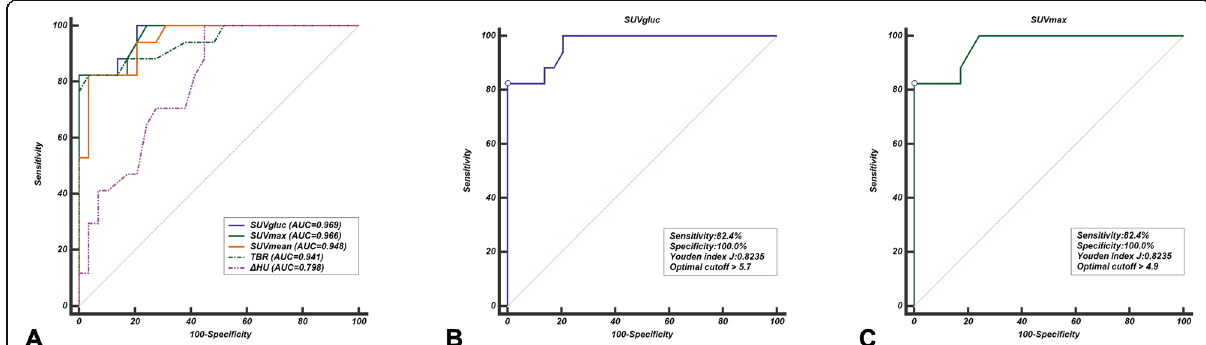
Fig. 3 ROC curves of the parameter of 18 F-FDG uptake and the enhancement. a The SUVgluc had a higher AUC value (0.969) discriminating between malignant and benign tumors than other parameters. b The SUVgluc cutoff value of 5.7 and c the SUVmax cutoff value of 4.9 yield the same 82.4% sensitivity and 100.0% specificity